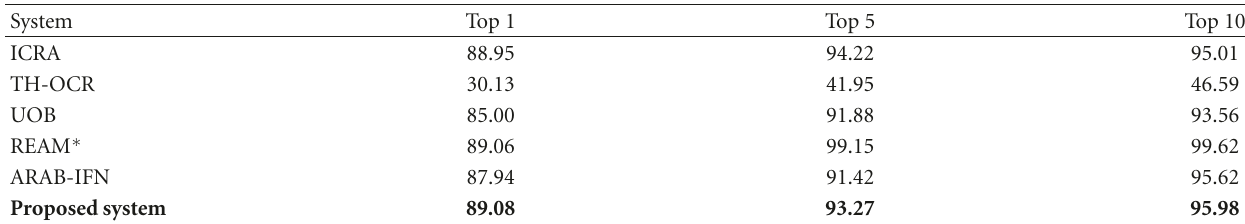
Table 3: Comparison with other word recognition systems which are presented in [41]: recognition results in % with the dataset d (6735